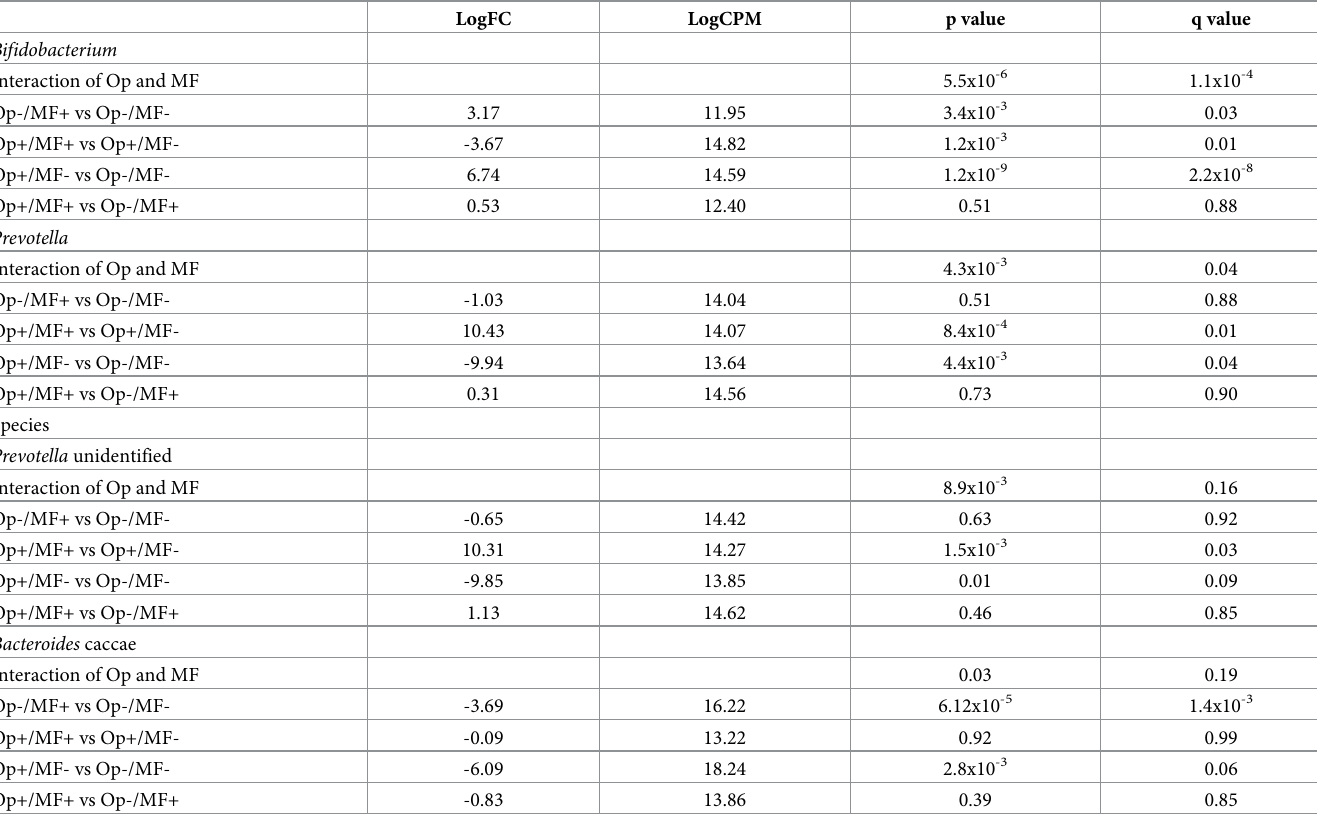
Table 4. The interactive influence of metformin and opioids on gut microbiota in the subgroup with diabetes.